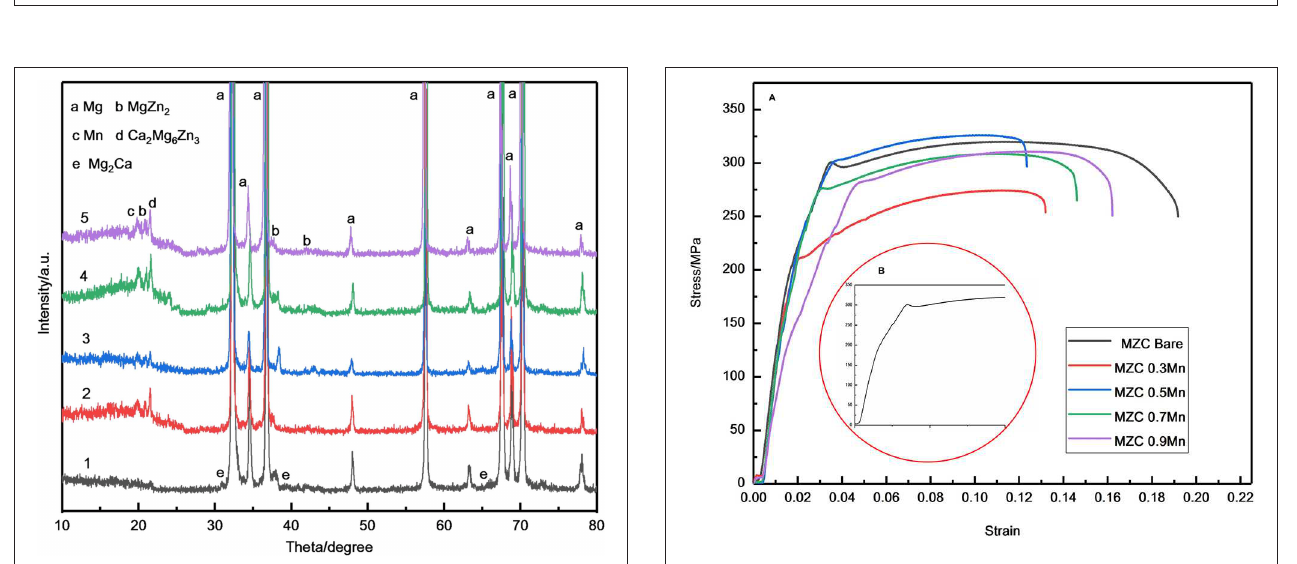
FIGURE 6 | The field-emission scanning images of as-extruded MZC (A) , MZC0.3Mn (B) , MZC0.5Mn (C) , MZC0.7 Mn (D) , and MZC0.9 Mn (E) alloys.